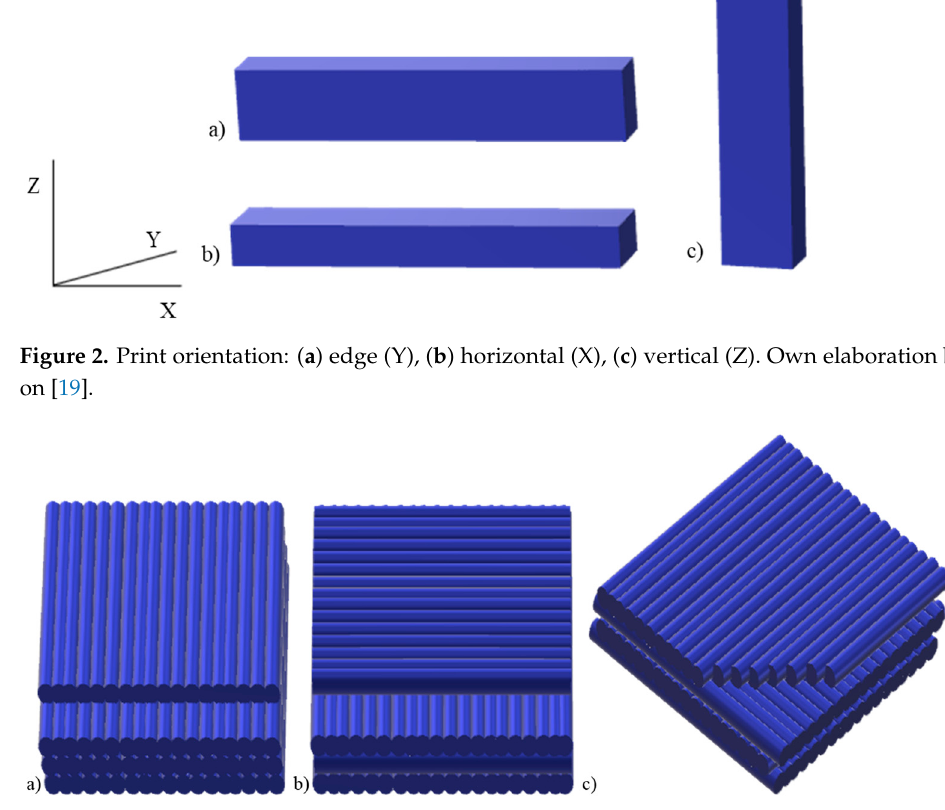
Figure 3. Raster orientation: ( a ) 0°, ( b ) 90°, ( c ) − 45°/ − 45°. Own elaboration based on [31].